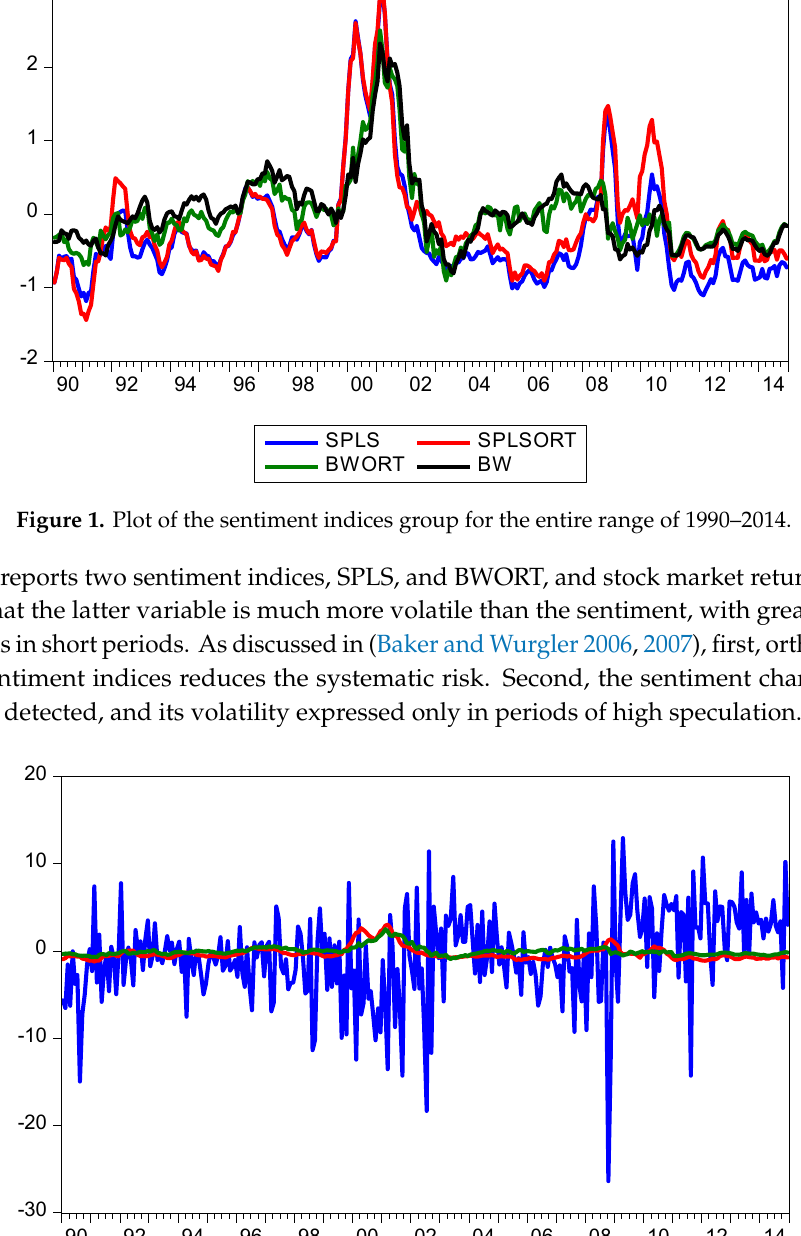
Table 1. Set of regressions run on the U.S. market.